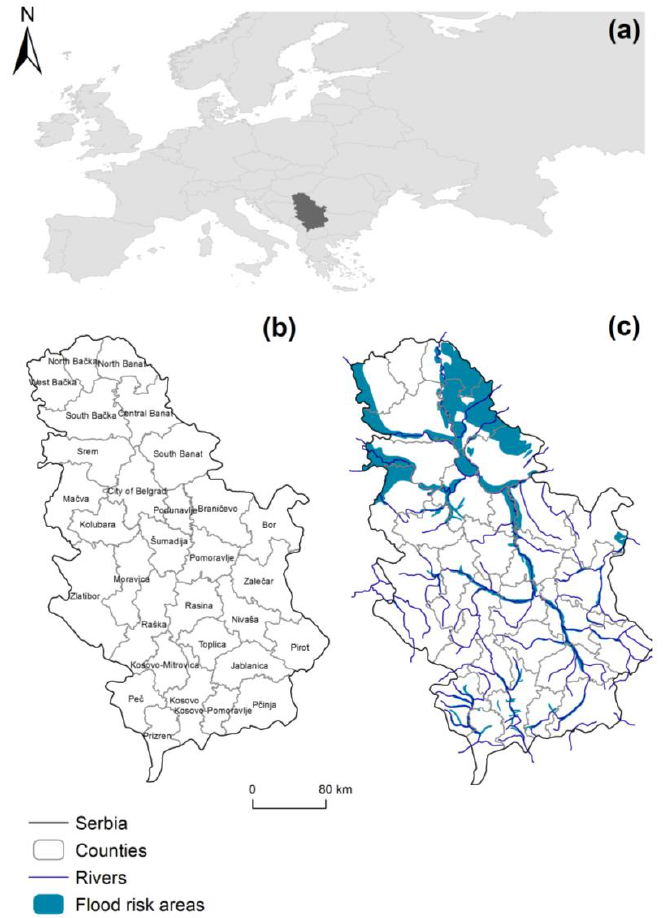
Figure 1. ( a ) Location of Serbia; ( b ) counties of Serbia; ( c ) flood prone areas with 100-year return period.